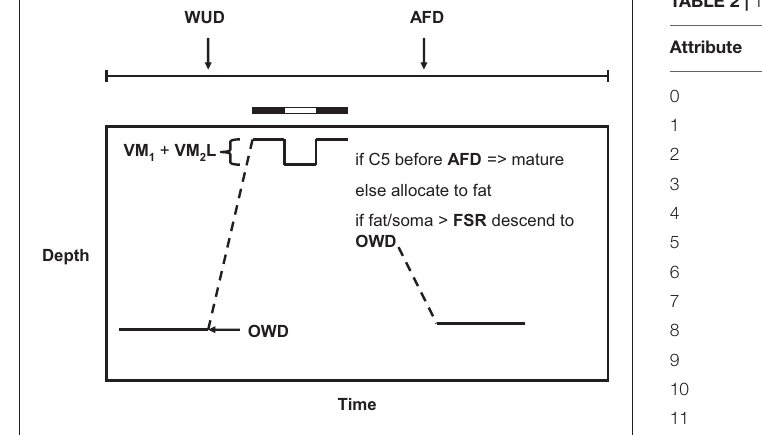
FIGURE 1 | The conceptual framework of the life history traits of the copepod IBM. The strategy variables, whose values are evolved during the spin up simulation, are given in bold. OWD is the overwintering depth, WUD is the date at which the overwintering C5 starts ascent toward the surface, VM 1 and VM 2 L gives the deepening of the copepod during day as a function of their length, AFD is the date after which an individual becoming C5 will prepare for overwintering, whereas before this date the individual will mature and reproduce in the same season, FSR gives the fat to soma ratio at which a C5 will descend to the OWD for overwintering in diapause.